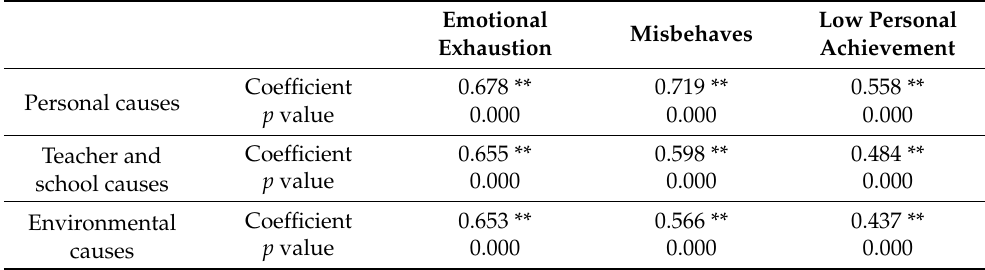
Table 4. Pearson Correlation analysis of the three types of burnout with the three causes.